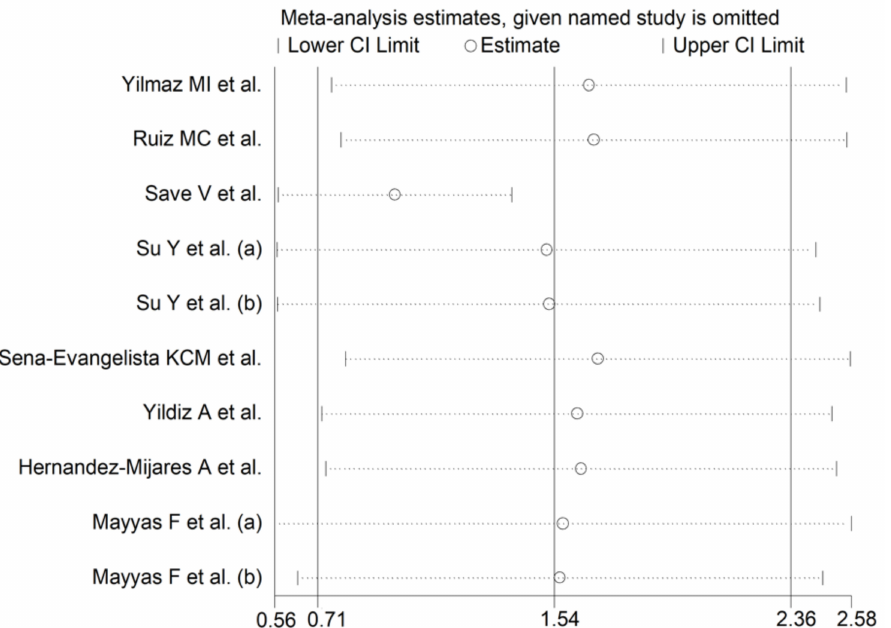
Figure 7. Sensitivity analysis describing the impact of individual studies on SOD on the standardized mean